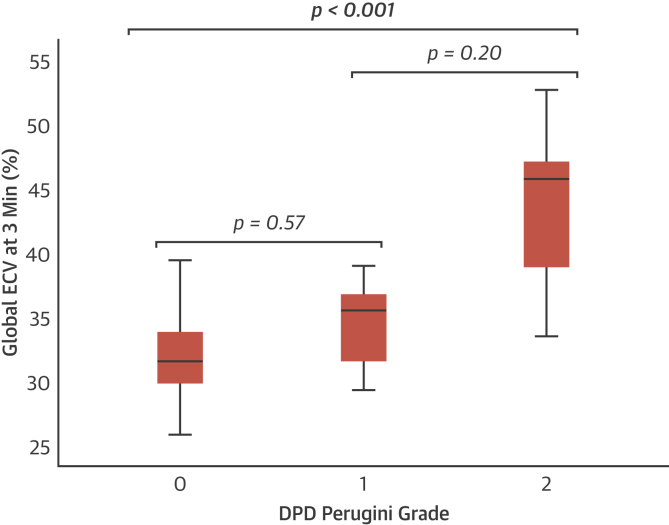
Box and Whisker Plot Showing the Variation in ECVCT Between DPD Perugini Gradesp < 0.001 for trend and for the pairwise comparison of grade 0 versus grade 2. Abbreviations as in Figures 1 and 2.